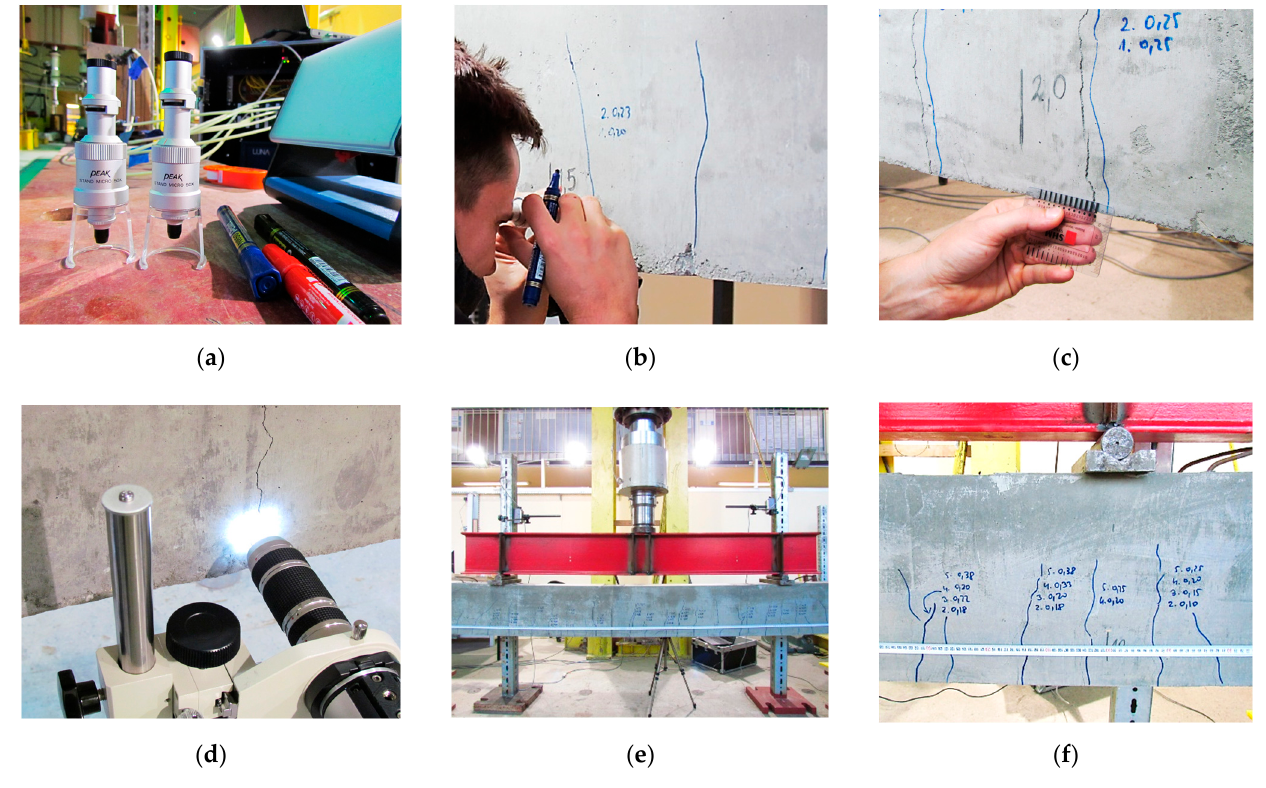
Figure 20. Crack documentation: ( a ) portable peak stand microscopes; ( b ) width measurement by optical microscope; ( c ) width measurement by plate crackmeter; ( d ) width measurement by digital microscope; ( e ) localising the cracks by metric tape; ( f ) close-up to the multiple cracks.